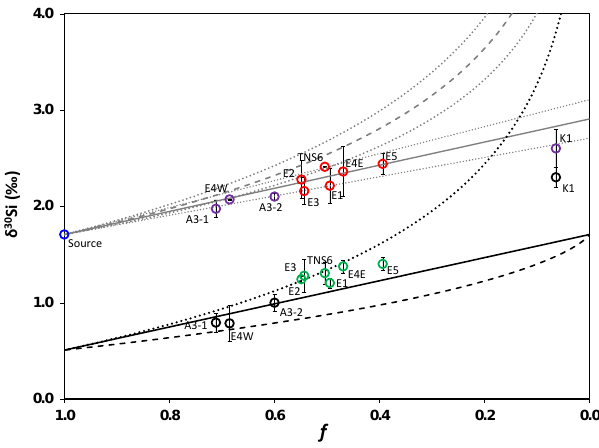
Figure 4. Silicon isotopic composition vs. remaining silicic acid ( f ) for the different ML Si reservoirs in the iron-fertilized areas of the Kerguelen Plateau. A unique source (averaged plateau WW, blue dot, 32.9 ± 2.2µmolSiL − 1 and 1.71 ± 0.03‰) was used for all plateau and meander stations. ML dissolved Si pools above the plateau (purple dots) and in the meander (red dots) fit well with a steady-state fractionation law (grey straight line) but not with a Rayleigh distillation law (grey broken line). The grey dotted line represents the 0.2‰ SD of the fractionation factor. Note that given the small uncertainty of the source DSi and δ 30 Si characteristics, we have neglected this uncertainty, which is minor compared to the SD on 30 ε . ML particulate Si pools above the plateau (black dots) and in the meander (green dots) lie between the instantaneous and accu- mulated products predicted by a Rayleigh distillation model (dotted and broken lines respectively). The straight black line represents the products in the steady-state model. Summer isotopic signatures (K1 for A3 KEOPS-1) are from Fripiat et al.